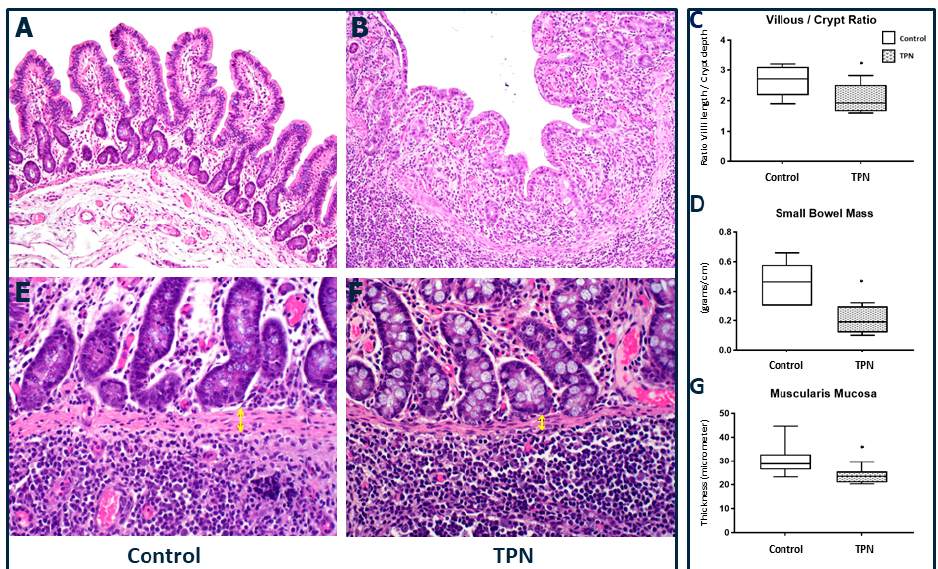
Figure 4. Small bowel histology. ( A – C ) Villous / crypt ratio (20 × magnification). Significant blunting of villi was found with TPN. ( D ) Gut mass of small bowel was lower with TPN. ( E – G ) Muscularis mucosa thickness (40 × magnification) was decreased in animals treated with TPN (yellow arrows). The figure shows box and whisker plots in which boxes represent the 25–75th percentile and center lines represent median values. A pairwise Mann–Whitney U test was conducted to determine the p -value. All tests were two-sided, using a significance level of 0.05.